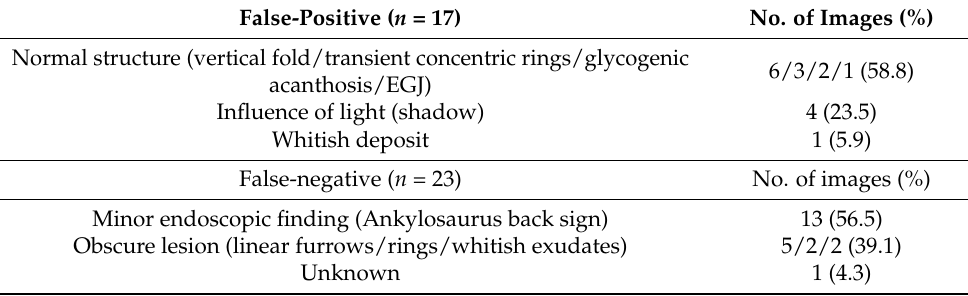
Table 4. Causes of false-positive and -negative results in CNN diagnosis. False-Positive ( n =